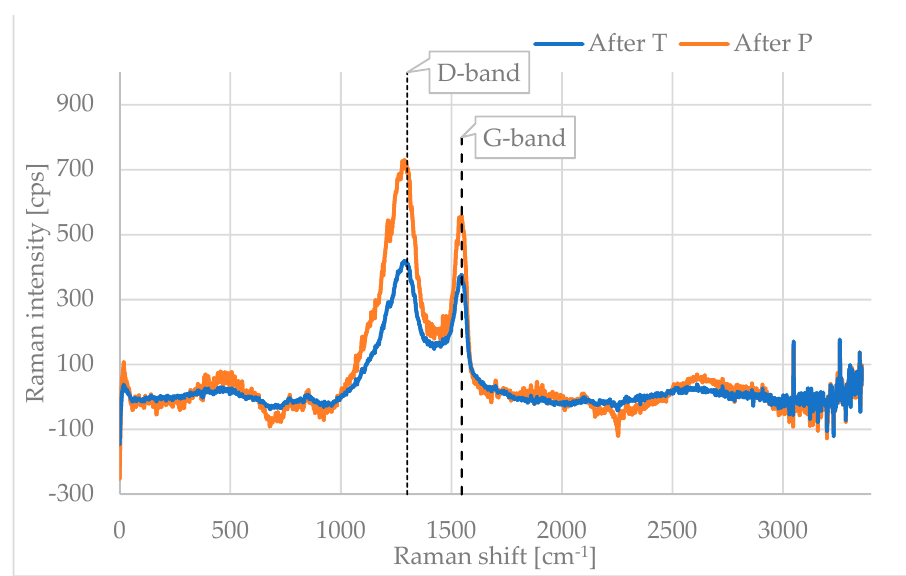
Figure 8. Comparison of the Raman spectra of the used catalysts.